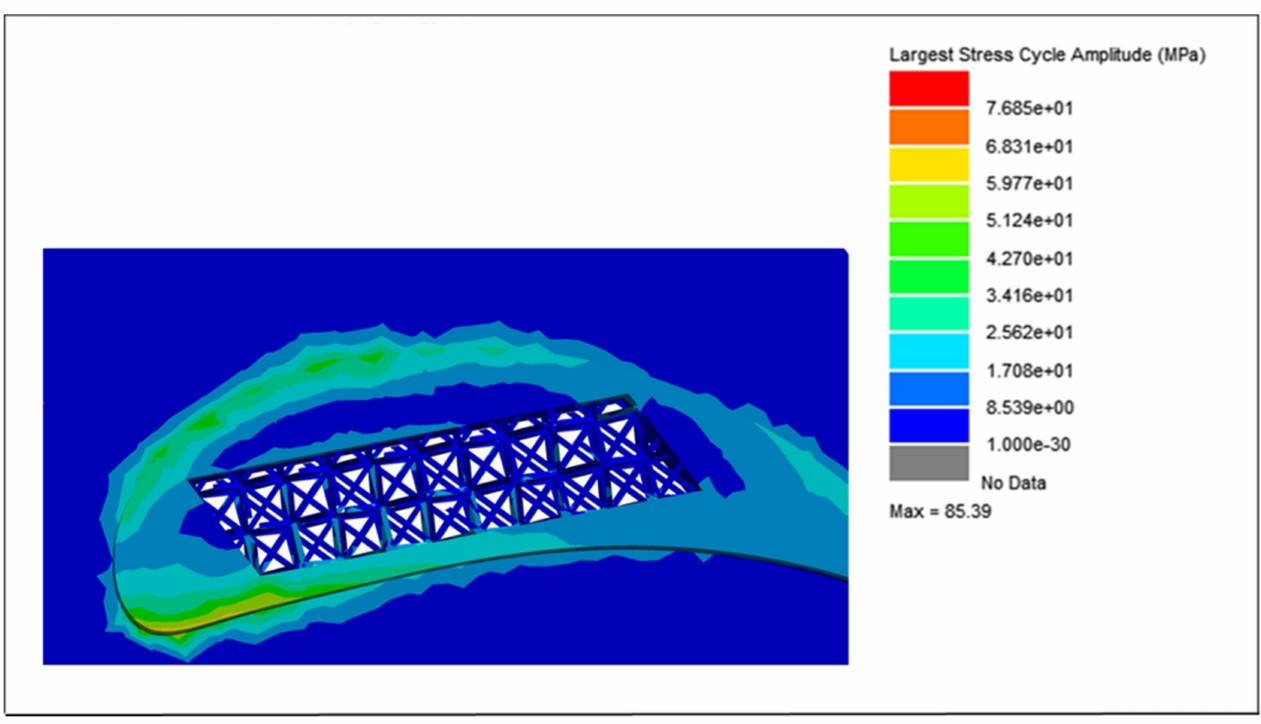
Figure 20. Largest stress cycle amplitude for the 0.50 mm lattice blade.